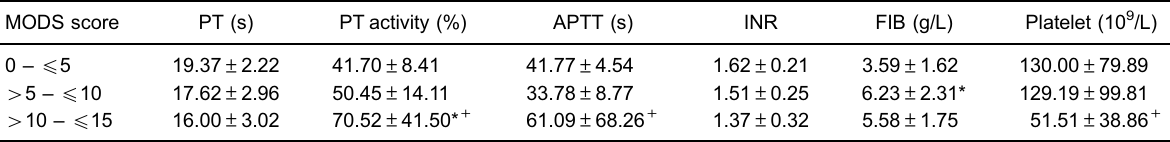
Data are reported as means ± SD. PT: prothrombin time; APTT: activated partial thromboplastin time; INR: international normalized ratio; FIB: fi brinogen. *P o 0.05, before-treatment vs after-treatment group, + P o 0.05, RCA vs hfBP group. Statistical analysis was performed with one-way